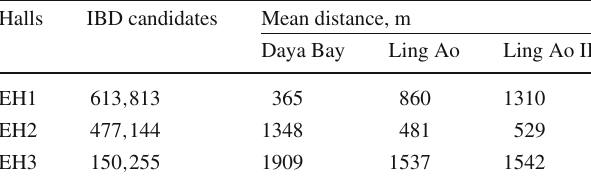
Table1 ThenumberofIBDcandidatesandmeandistancesofthethree experimental halls to the pairs of reactor